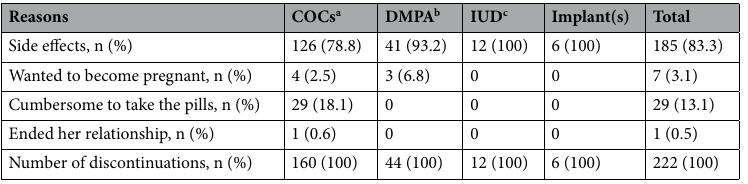
Table 2. Distribution of the main reason for discontinuation by contraceptive (n = 222). a COCs: Combined oral contraceptive pills. b DMPA: Depot medroxyprogesterone acetate. c IUD: Copper intrauterine device.